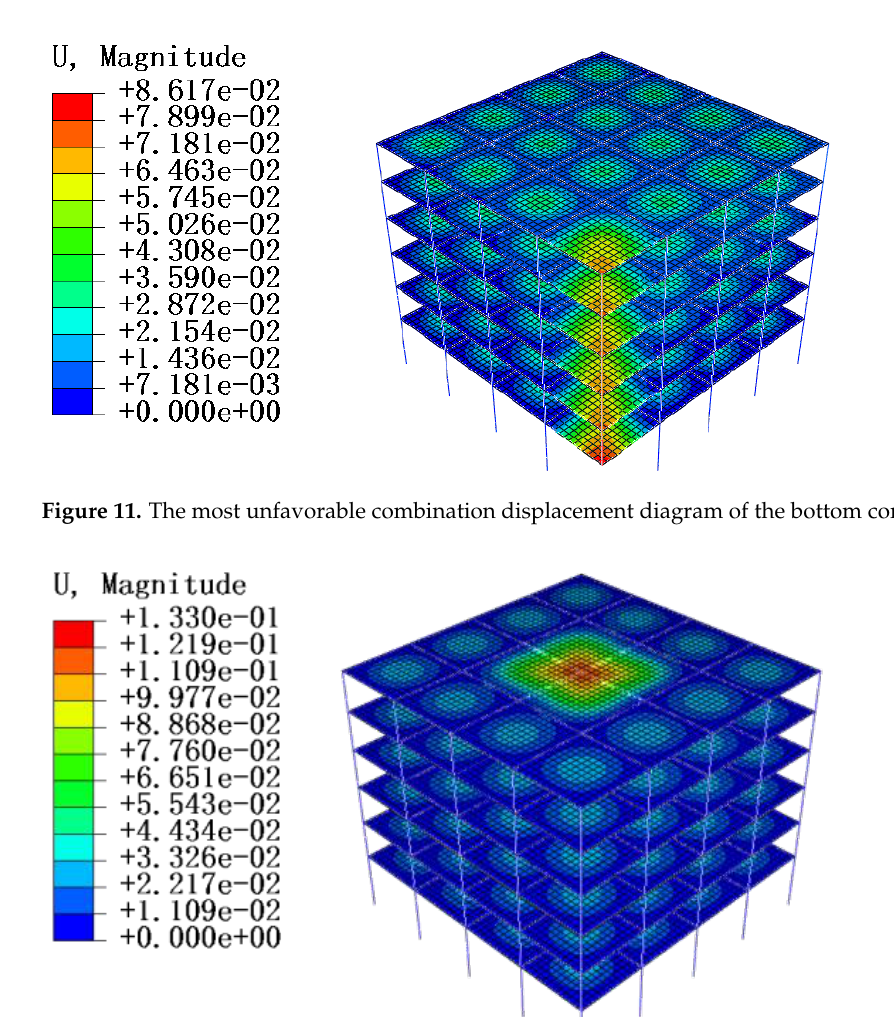
Figure 10. The most unfavorable combination displacement diagram of the bottom side column.